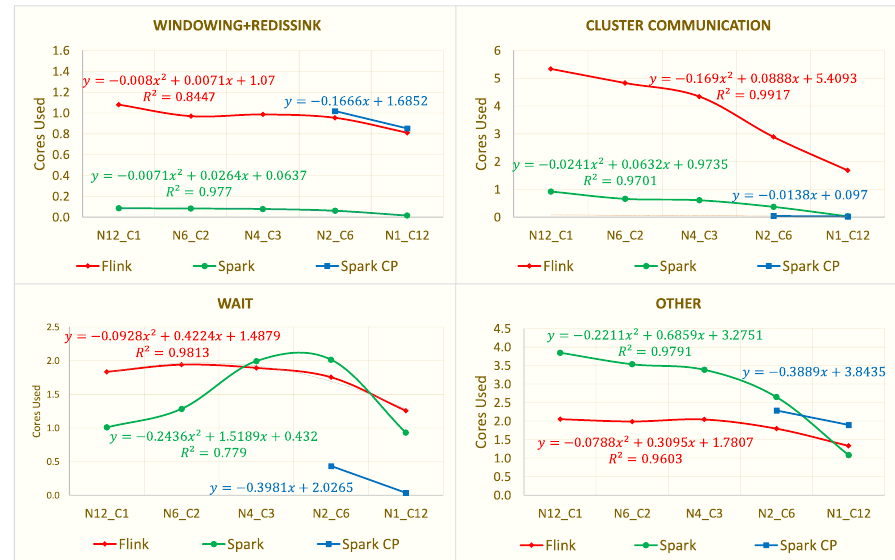
Figure 11. CPU consumption per task and cluster configuration.